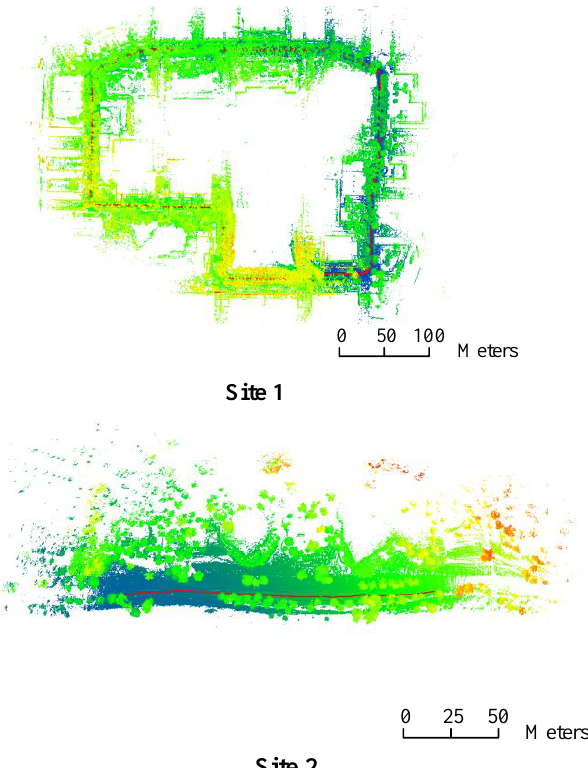
Figure 7. Mapping result of two typical scenes (trajectory represents in red lines)